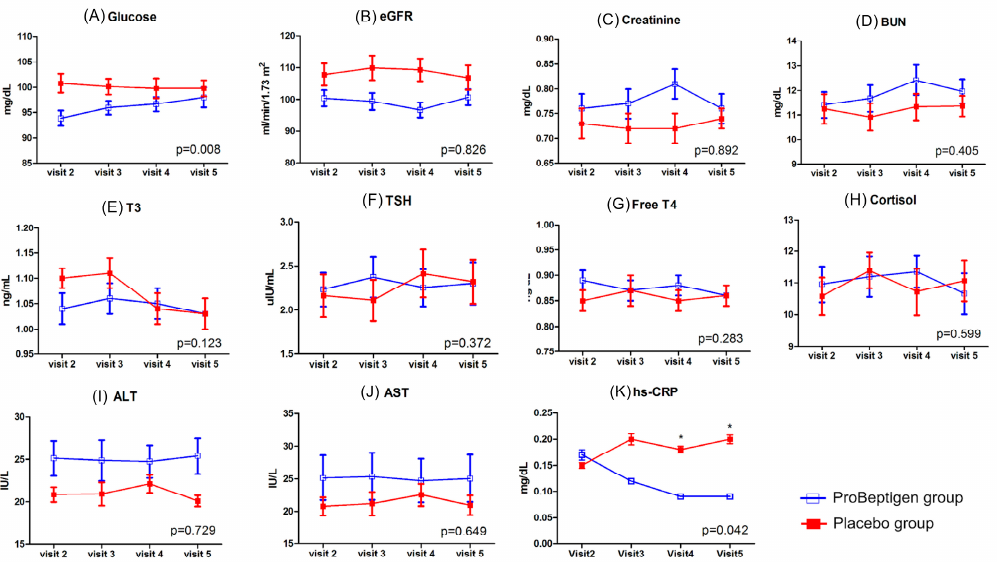
Figure 6. Changes of biochemistry profiles. ( A ) Glucose, ( B ) Estimated glomerular filtration rate (eGFR), ( C ) Creatinine, ( D ) Blood urea nitrogen (BUN), ( E ) Triiodothyronine (T3), ( F ) Thyroid-stimulating hormone (TSH), ( G ) Free thyroxine (Free T4), ( H ) Cortisol, ( I ) Alanine transaminase (ALT), ( J ) Aspartate aminotransferase (AST), ( K ) High-sensitivity C-reactive protein (hs-CRP). Error bars represent standard errors. The p -value shown in each diagram denotes the statistics of time × treatment interaction after considering the baseline data as a covariate and the asterisk denotes a statistically significant between-group difference at the specific visit time.